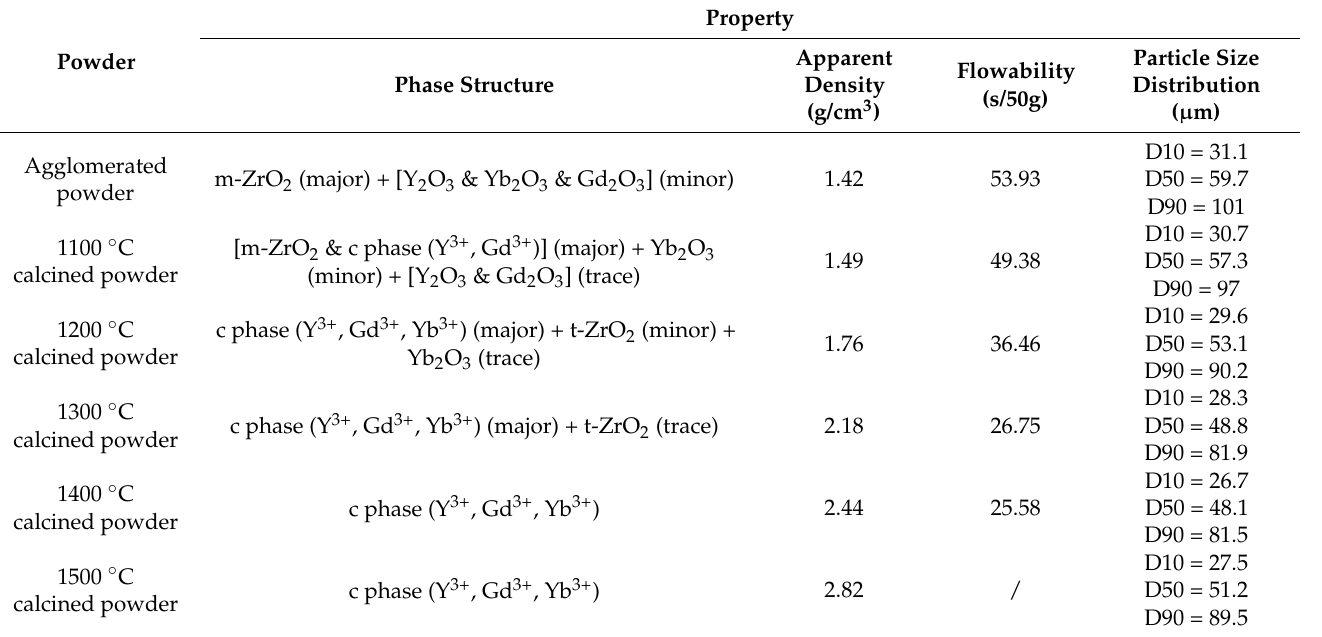
Table 3. Summary of properties of agglomerated powder and different calcined powders. Powder